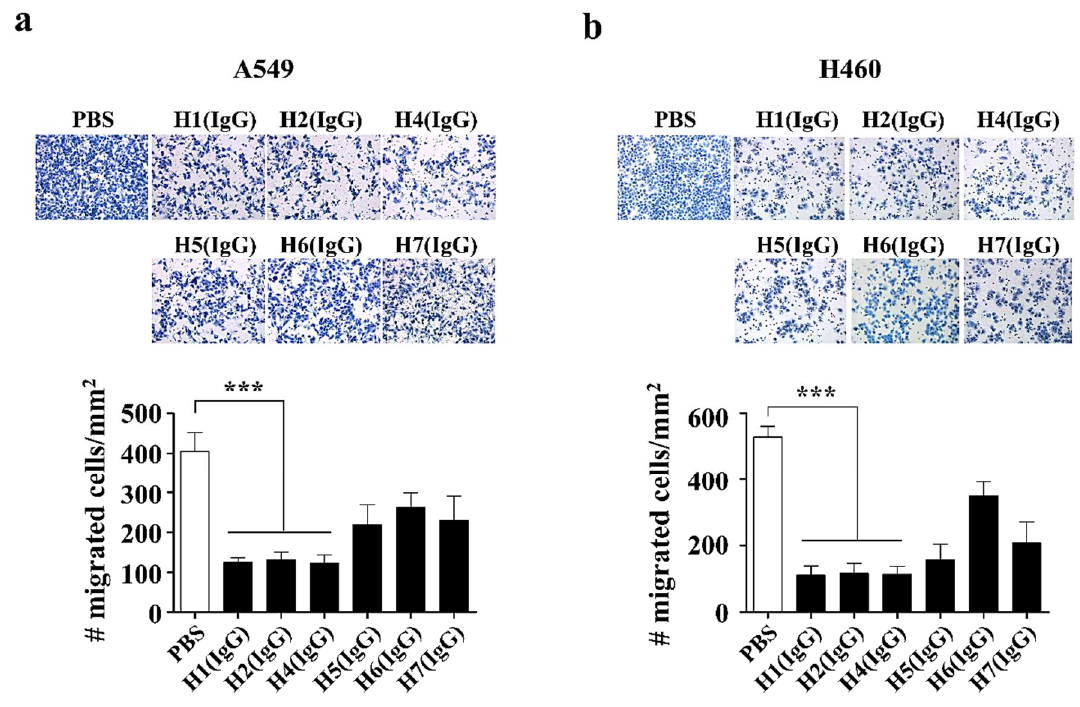
Figure 4. Trans-well migration assay of human anti-hYKL-40 IgGs. ( a,b ) Trans-well migration assay of human anti-hYKL-40 IgGs (H1 (IgG), H2 (IgG), H4 (IgG), H5 (IgG), H6 (IgG), and H7 (IgG)) on A549 ( a ) and H460 ( b ) cells to assess their inhibitory effects in cell migration. The number of migrated cells per square mm (mm 2 ) was counted, plotted and compared to that of a negative control (PBS (phosphate-buffered saline)-treated). The data are presented as the mean ± SE (SEM). *** p < 0.001.